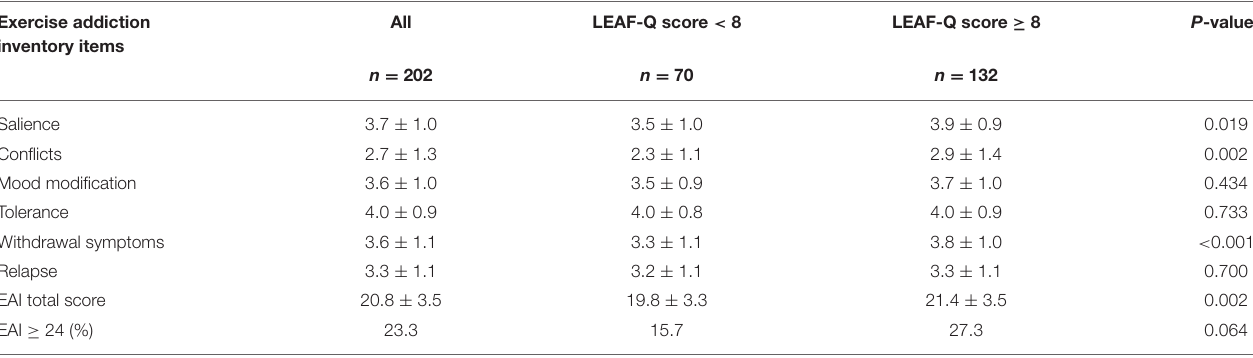
TABLE 3 | Symptoms of exercise addiction characterized by energy availability